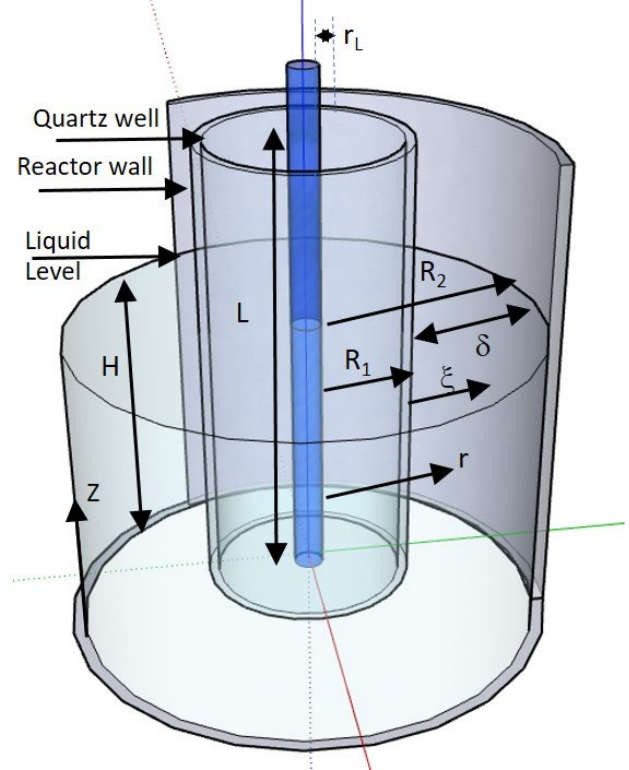
Figure 1. Scheme of the central lamp photoreactor and principal dimensions.